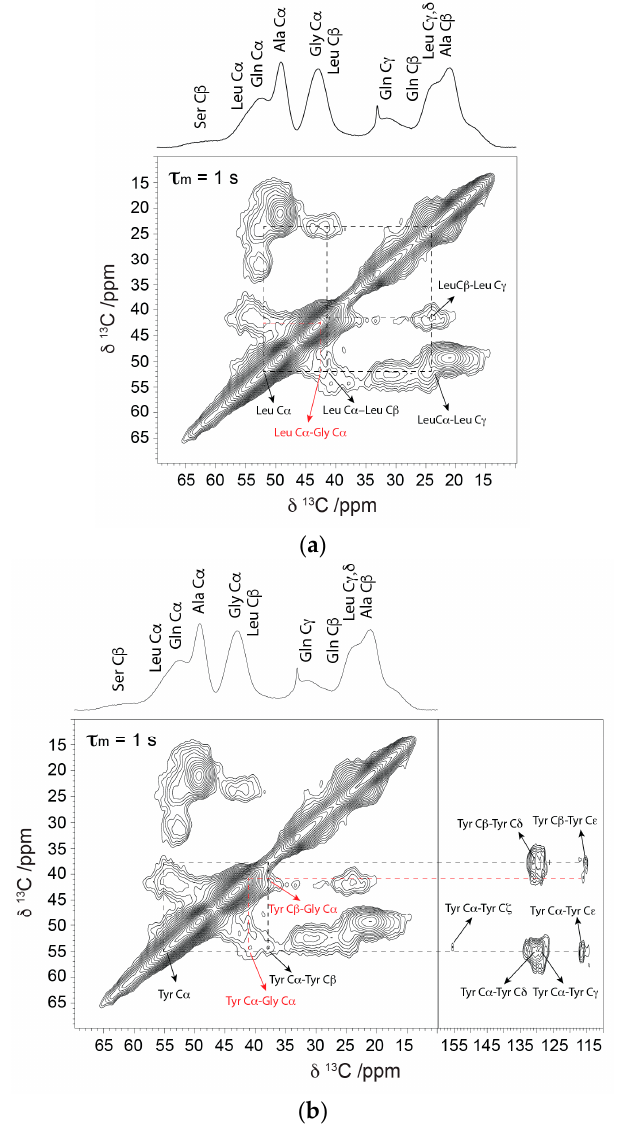
Figure 2. 13 C– 13 C correlation spectrum collected with a long dipolar assisted rotational resonance (DARR) mixing period of 1 s. Short range (intra-residue) and long range (inter-residue) dipolar contacts are indicated with dashed black lines. Long range dipolar contacts for ( a ) Leu-Gly and ( b ) Tyr-Gly present in Gly-Gly-X repeats are indicated in red.